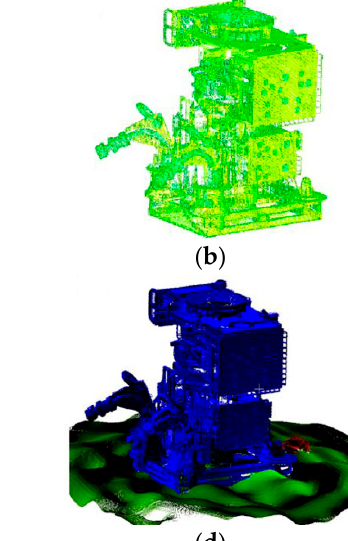
11 of 20 Figure 5. Comparison between virtual scene module camera preview and each synthetic point cloud generated per sensor scanning position [29]. Each point in these clouds has the following properties: • 3D coordinates: Define the position of the point associated with the constructed virtual scene (x,y,z). It is the basic information of a point cloud. The visualization of the points is shown in Figure 6a; •